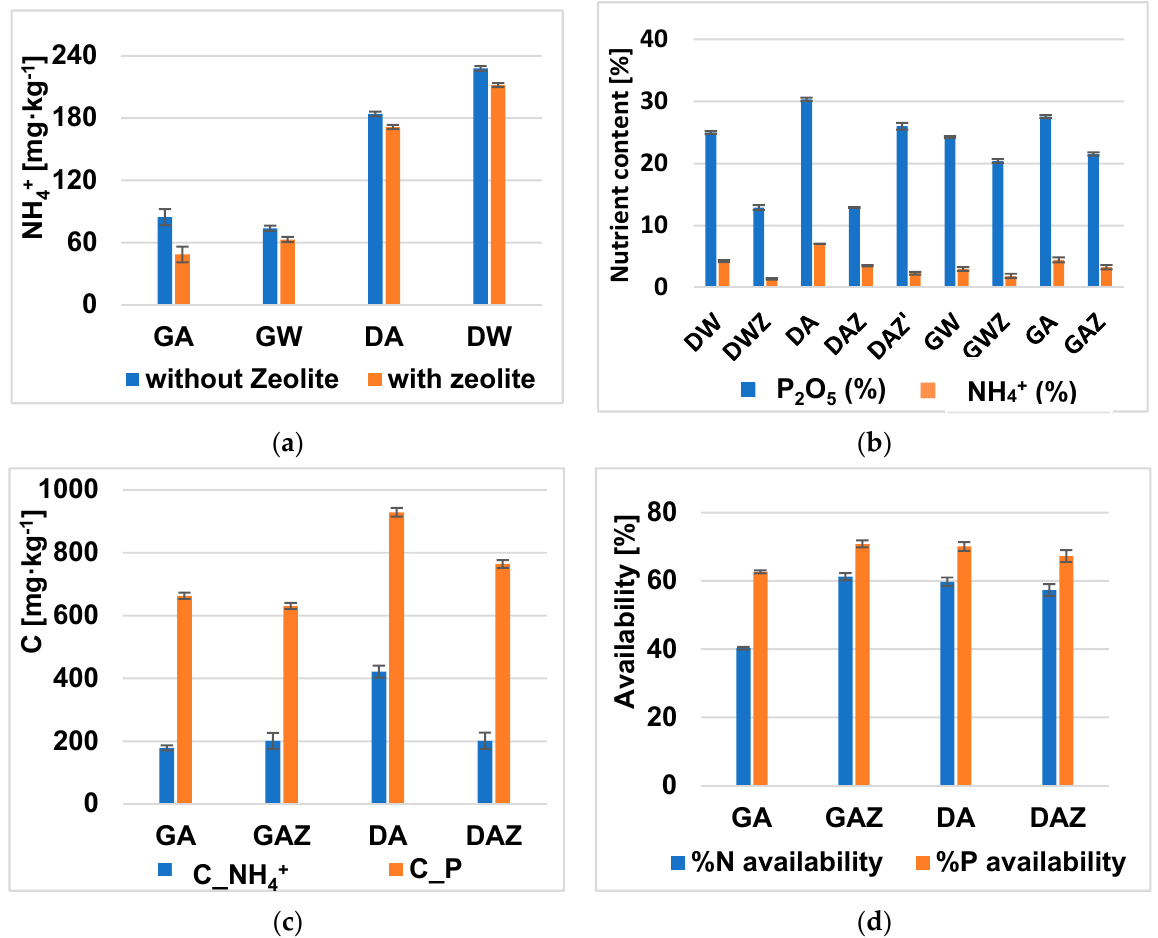
Figure 3. Comparison of ammonium concentration in effluents obtained from ( a ) GA: batch applied from gradient with artificial solution (GA) and real Wastewater sample (GW); batch applied from desirability approach with artificial (DA) and real Wastewater (DW); ( b ) Nitrogen and phosphorus content in their experimental products without and with zeolite (GAZ, GWZ, DAZ, DWZ); their nutrient availability in citric acid as concentration ( c ) after 2 h; and as % ( d ) of dissolved product